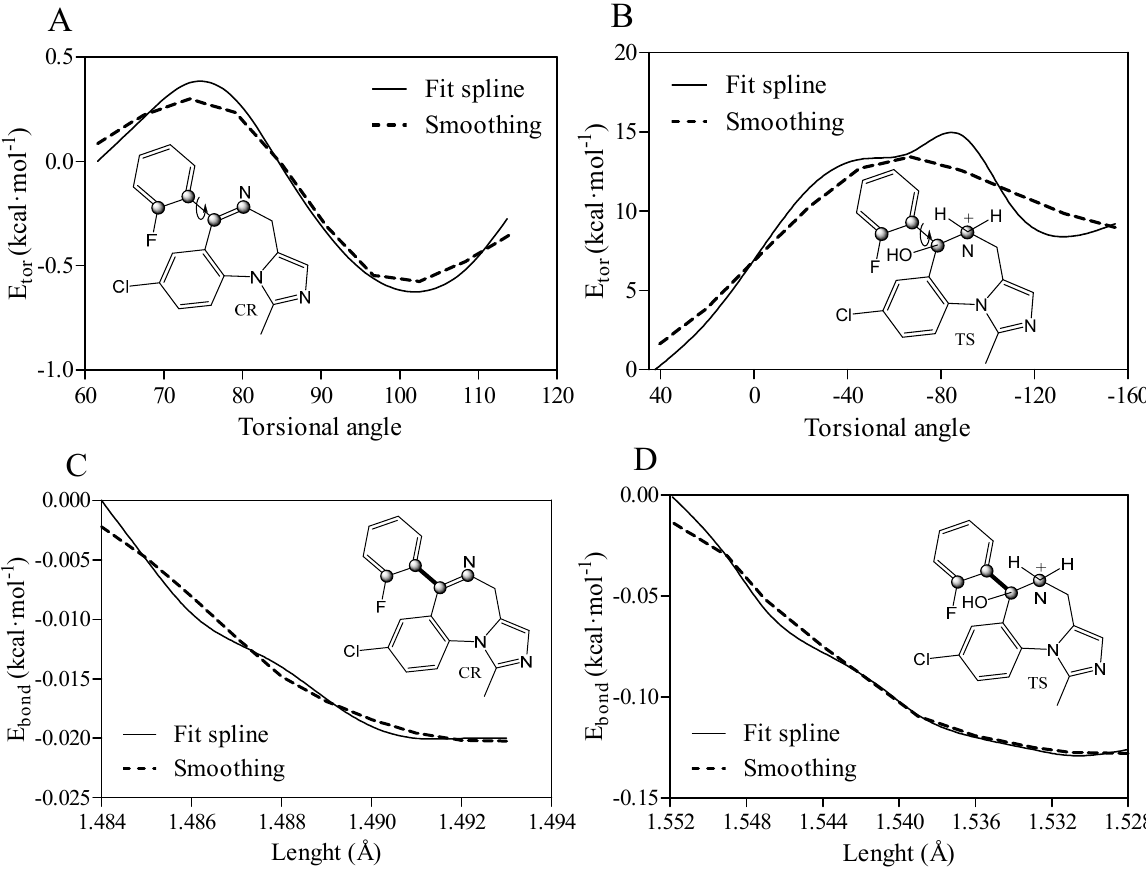
Figure 6. Predicted relative torsional ( (cid:1831) ) energy ( A , B ) and bond length ( (cid:1831) ) (cid:3047)(cid:3042)(cid:3045) (cid:3029)(cid:3042)(cid:3041)(cid:3031) energy ( C , D ) for closed-ring (OR) and transition state (TS) forms of midazolam complexed with TRIMEB. A fit spline and smoothing curves are implemented to connect and fit the data points. All atoms comprising the torsional angle are depicted as grey spheres and measured bonds are illustrated as bold